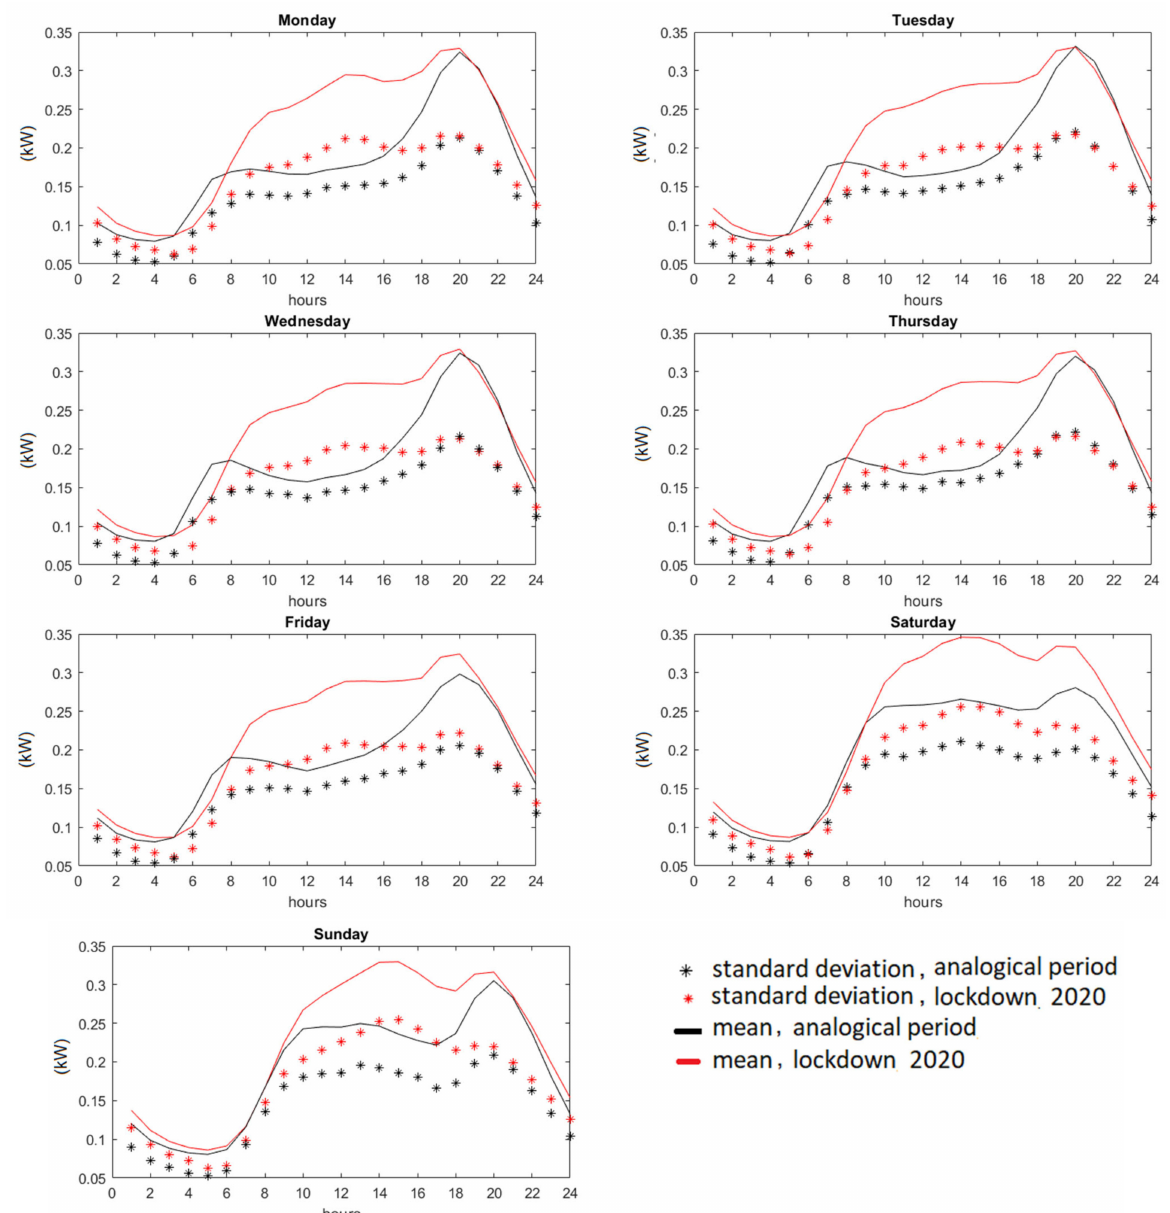
Figure 12. Averaged profiles of the daily active power load of residential users on particular days of the week (averaged over 1-h intervals), based on the averaging of the set of dwellings, including the lockdown period in 2020 and the corresponding period of 2018: continuous lines present usage profiles, and points refer to standard deviations of values at a given hour of the